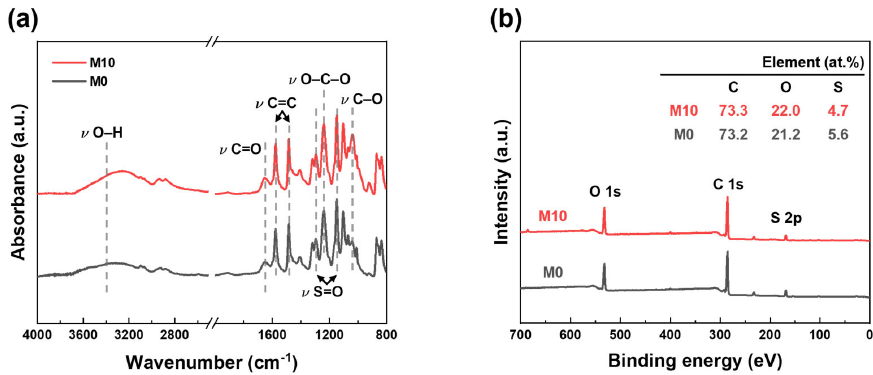
Figure 4. Chemical properties of PES and FCNT/PES nanocomposite HF membranes. ( a ) ATR-FTIR spectra. ( b ) XPS spectra.